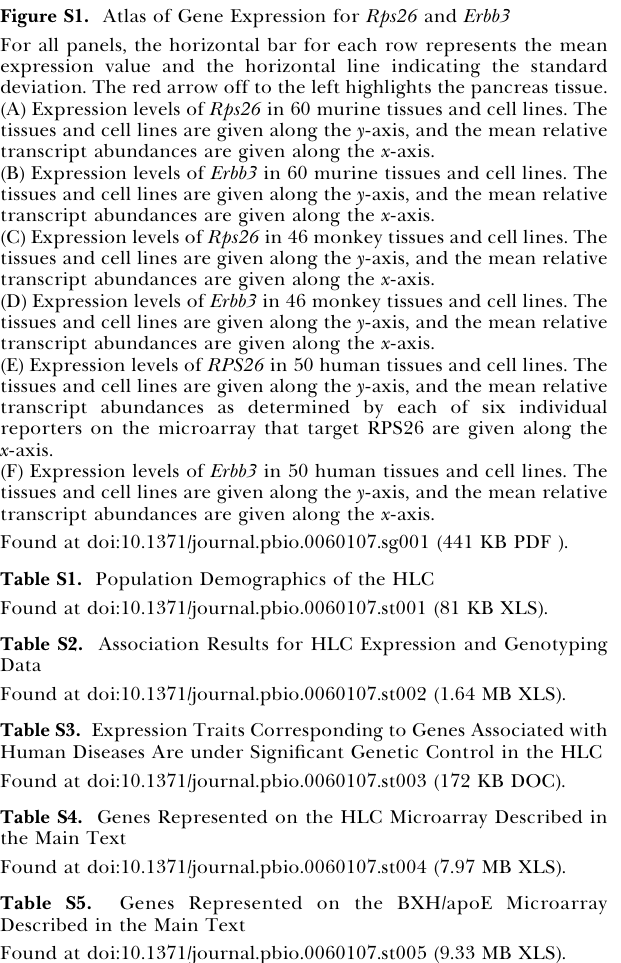
Table S6. Genes Represented on the BXH/wt and BXC Microarray Described in the Main